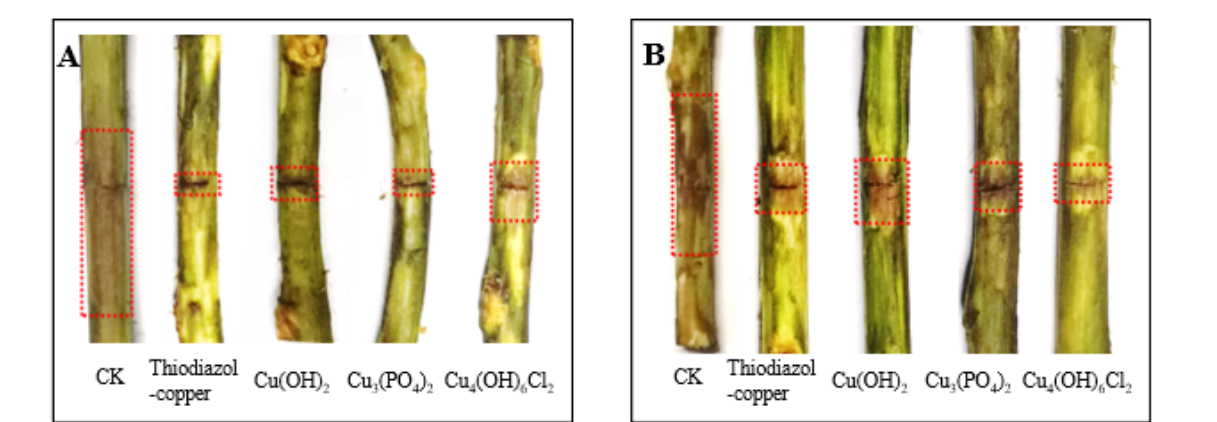
Figure 3. The interaction between the bacteria and nanoparticles. TEM and SEM images of Psa cells exposed to PBS ( A-1 , B-1 ), Cu(OH) 2 nanowires ( A-2 , B-2 ), Cu 3 (PO 4 ) 2 ·3H 2 O nanosheets ( A-3 , B-3 ), and Cu 4 (OH) 6 Cl 2 nanoparticles ( A-4 , B-4 ) for 8 h with a concentration of 50 μ g/mL. Fluorescence images of Psa cells incubated with PI or CM − H 2 DCFDA after being exposed to PBS ( C-1 , D-1 ), thiodiazole copper ( C-2 , D-2 ), Cu(OH) 2 nanowires ( C-3,D-3 ), Cu 3 (PO 4 ) 2 ·3H 2 O nanosheets ( C-4,D-4 ), and Cu 4 (OH) 6 Cl 2 nanoparticles ( C-5 , D-5 ) for 8 h with concentration of 50 μ g/mL.